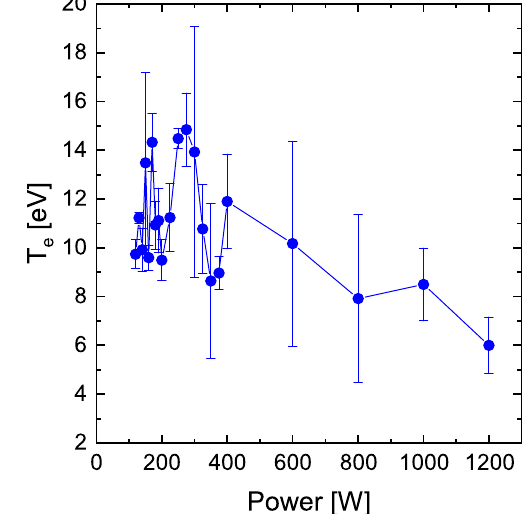
FIG. 5. Electron temperature evaluated via OES when increas- ing the rf